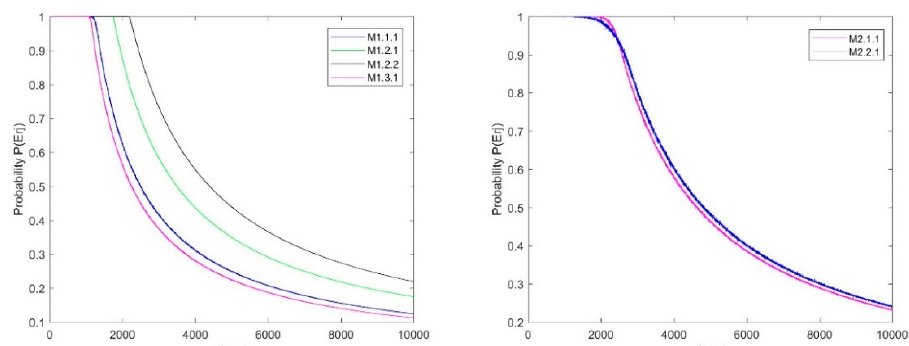
Figure 7. WIP qualification rate over time.